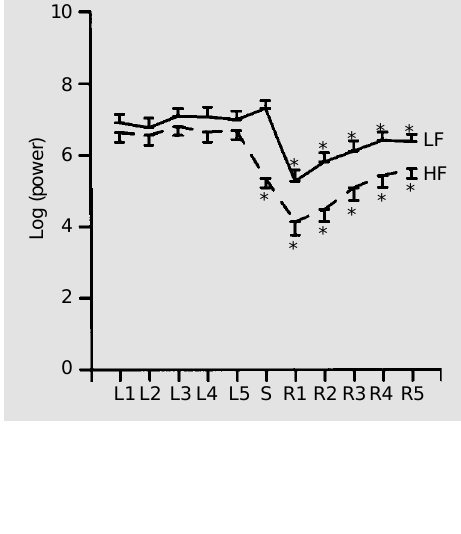
R5SL3Figure 4. Changes of sample en-